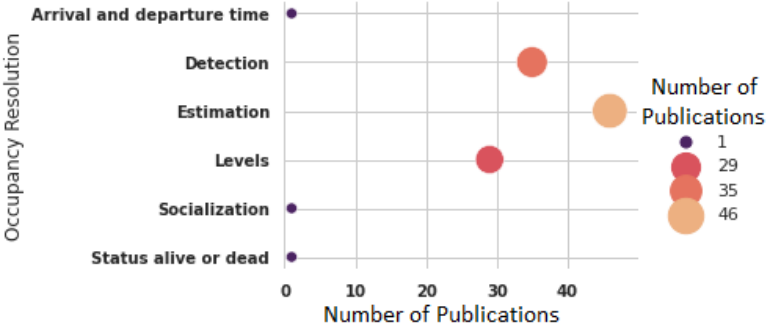
Figure 9. Publications by indoor occupancy